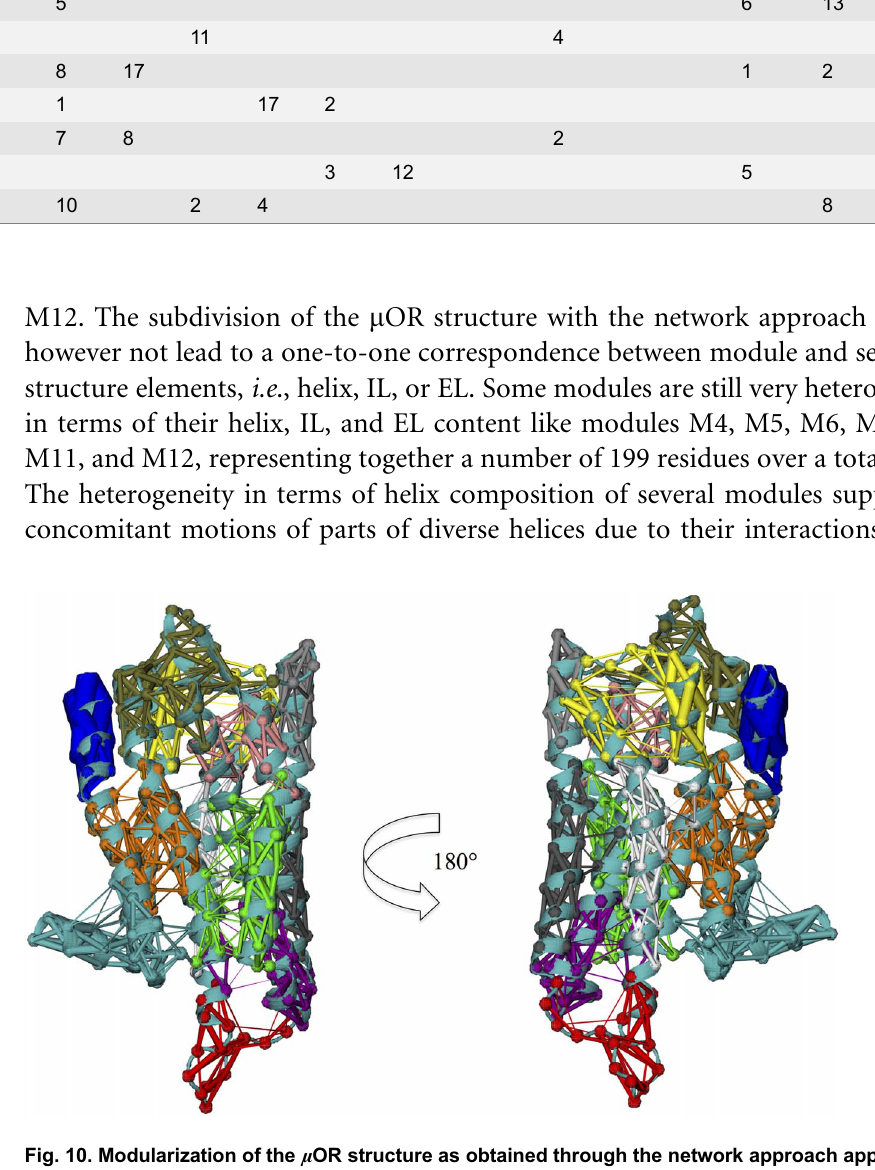
Fig. 10. Modularization of the m OR structure as obtained through the network approach applied to the 0.5 m s MD simulation. The twelve resulting modules are M1 (blue), M2 (red), M3 (gray black), M4 (orange), M5 (yellow), M6 (brown), M7 (gray), M8 (green), M9 (white), M10 (pink), M11 (cyan), and M12